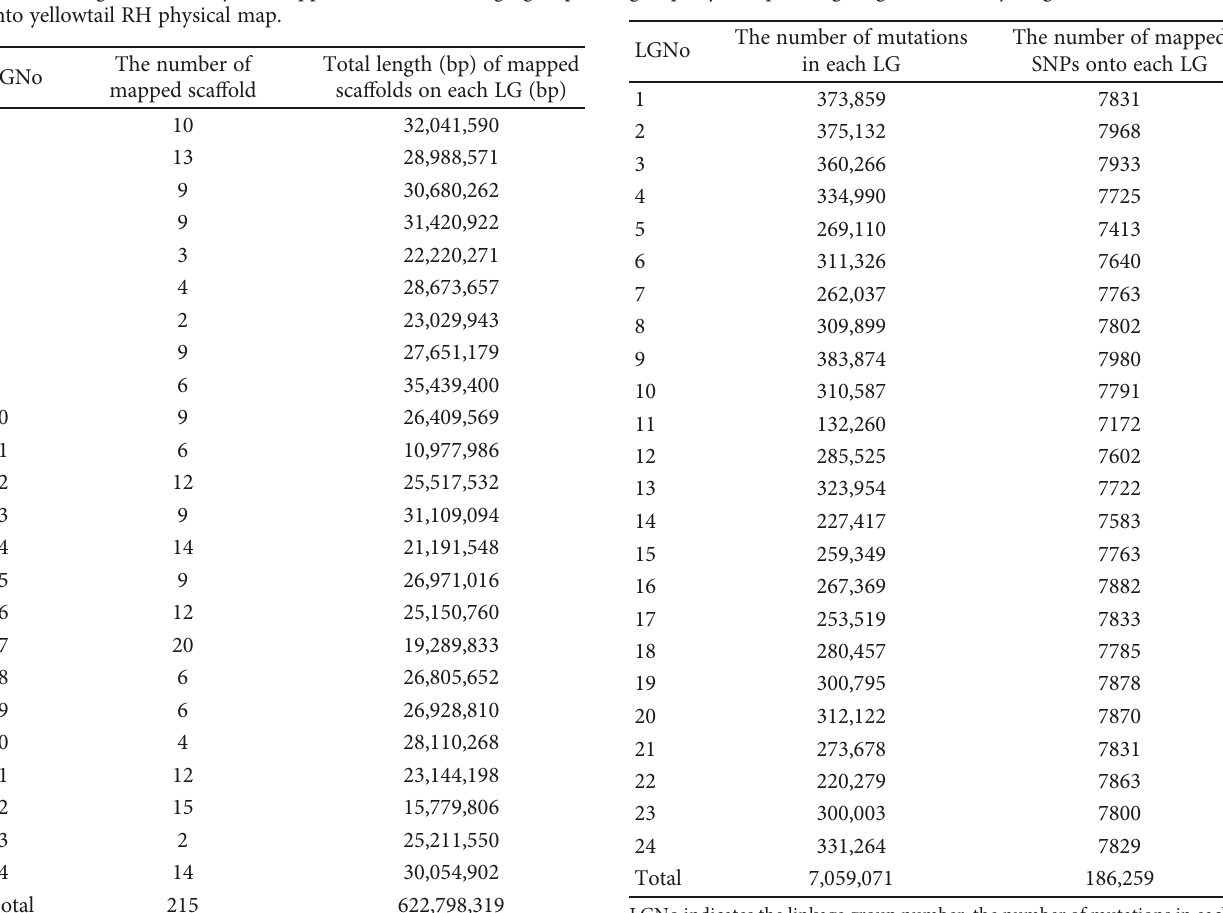
Table 3: Summary of nonredundant SNPs mapped to the 24 linkage groups by resequencing 20 greater amberjack genomes.